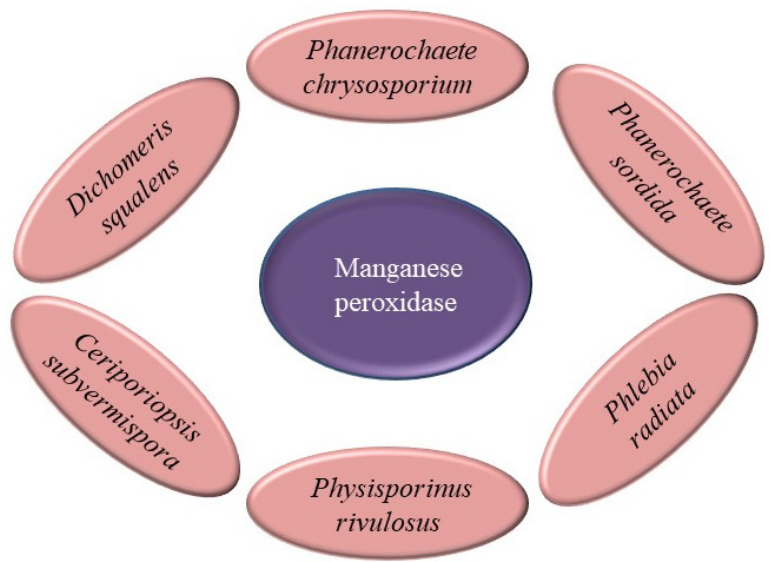
Figure 16. Some of the fungi that secrete Manganese peroxidase.